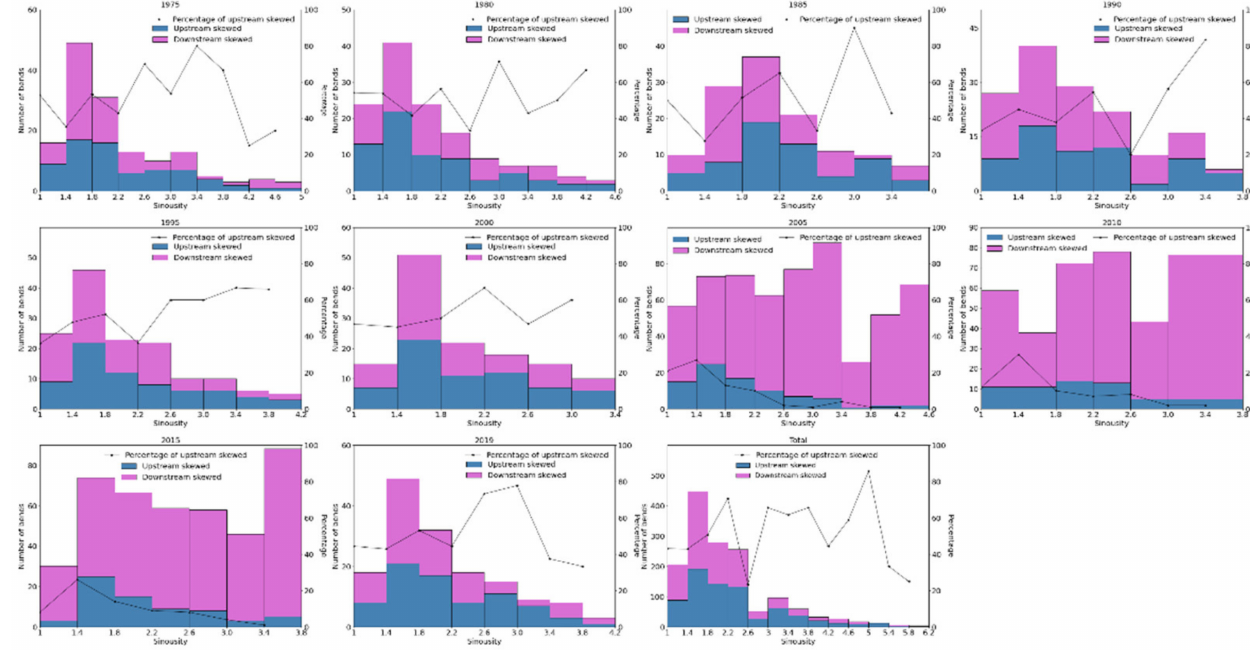
Figure 7. The distribution of sinuosity and skewing angle of all the 1499